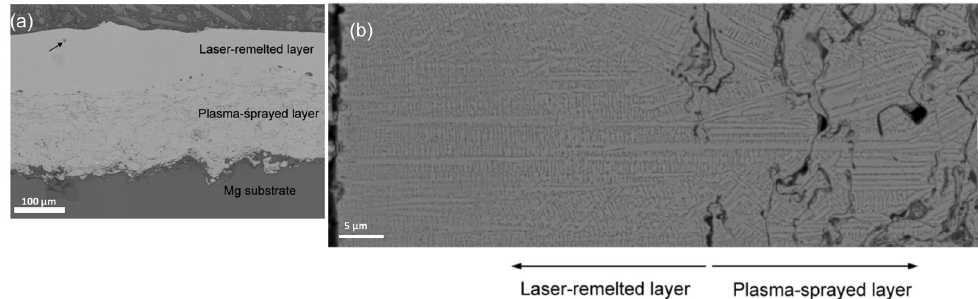
Figure 8. ( a ) A cross-sectional backscattered SEM image of AlCoCrCuFeNi coated on an Mg substrate showing the as-sprayed layer and a laser-remelted layer. ( b ) A high-resolution backscattered SEM image showing the epitaxial growth of columnar dendrites at the laser-remelted layer [53]. As mentioned above, rapid cooling rates allow HEA coatings to possess a precipitate- free microstructure. Annealing and/or laser remelting often promote the formation of pre- cipitates [29,44,45,54]. The size and distribution of precipitates can be changed by tuning